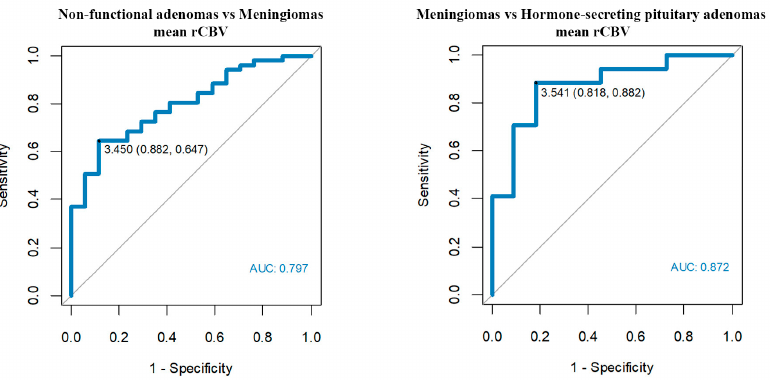
Figure 5. Optimum rCBV cut-off points among meningiomas, non-functional pituitary adenomas and hormone-secreting adenomas.